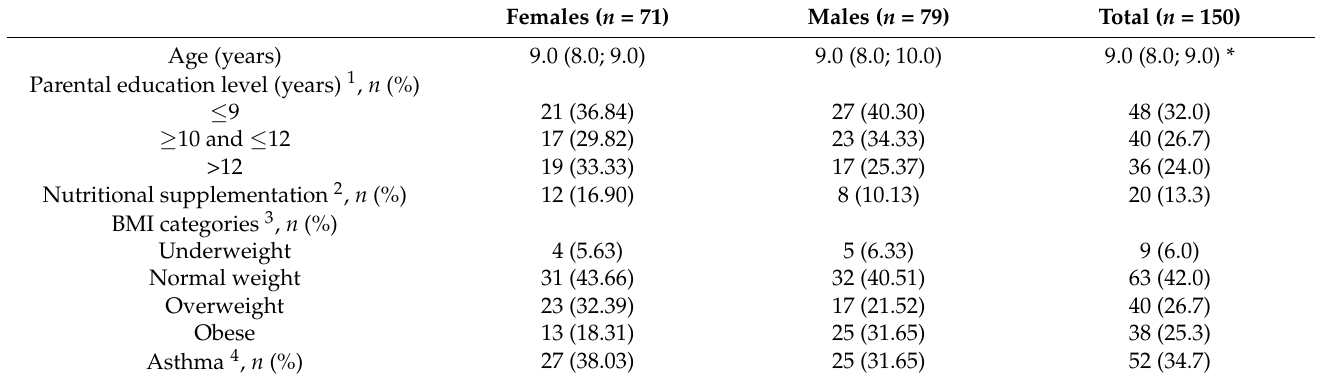
Table 1. Participants’